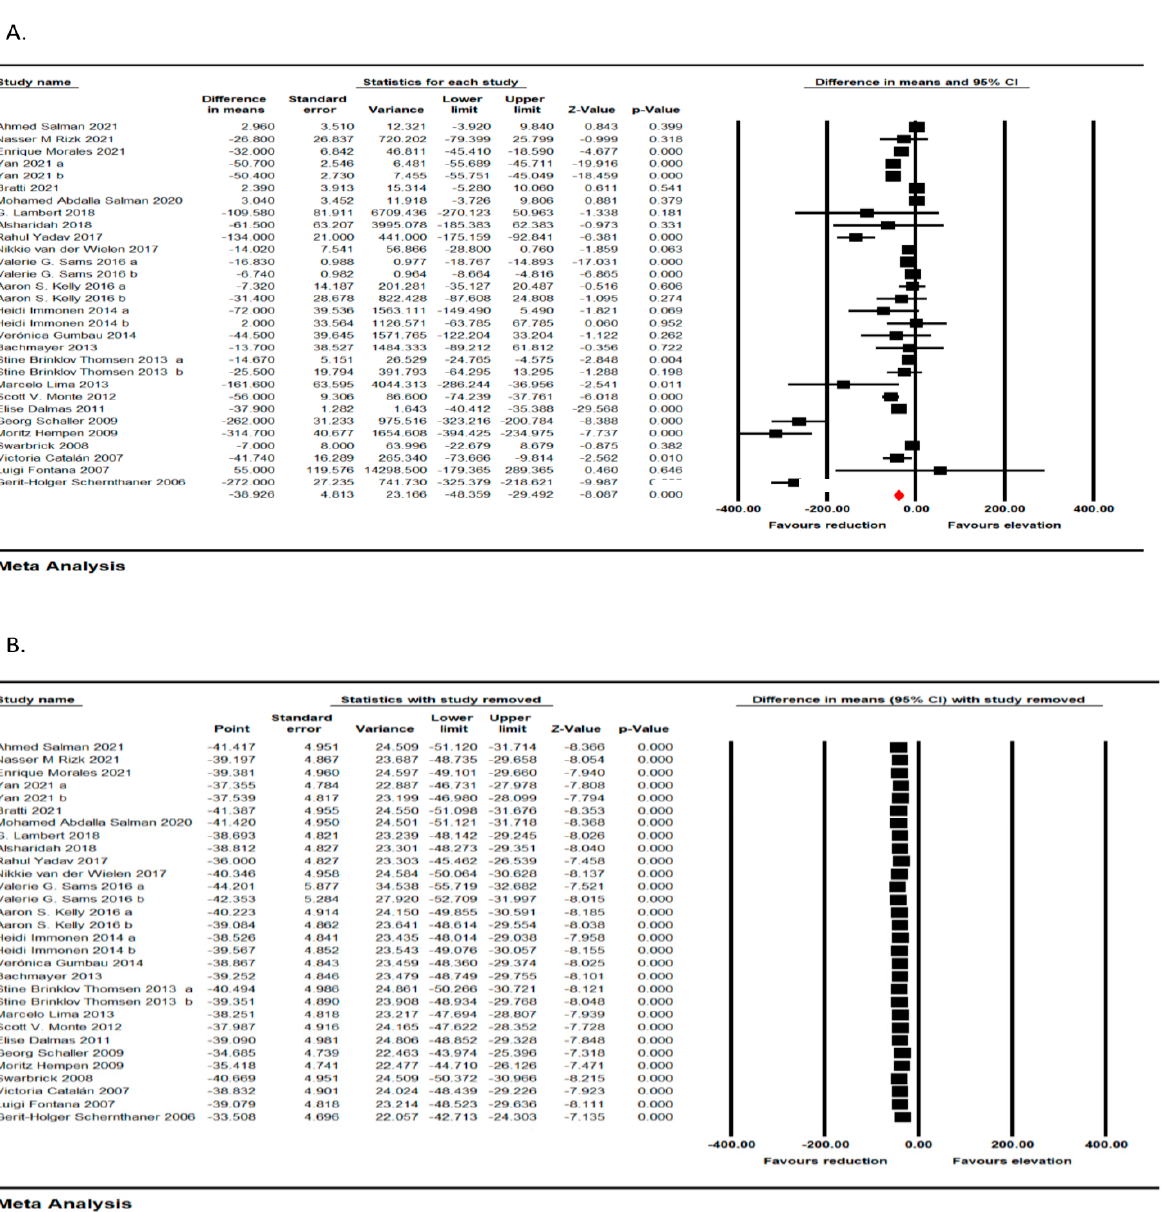
Figure 2. ( A ). Forest plots representing standardized mean difference and 95% confidence intervals (CIs) for the effect of bariatric surgery on MCP-1; ( B ). Leave-one-out sensitivity analysis for the effect (CIs) for the effect of bariatric surgery on MCP-1; ( B ) Leave-one-out sensitivity analysis for the effect of bariatric surgery on MCP-1. of bariatric surgery on